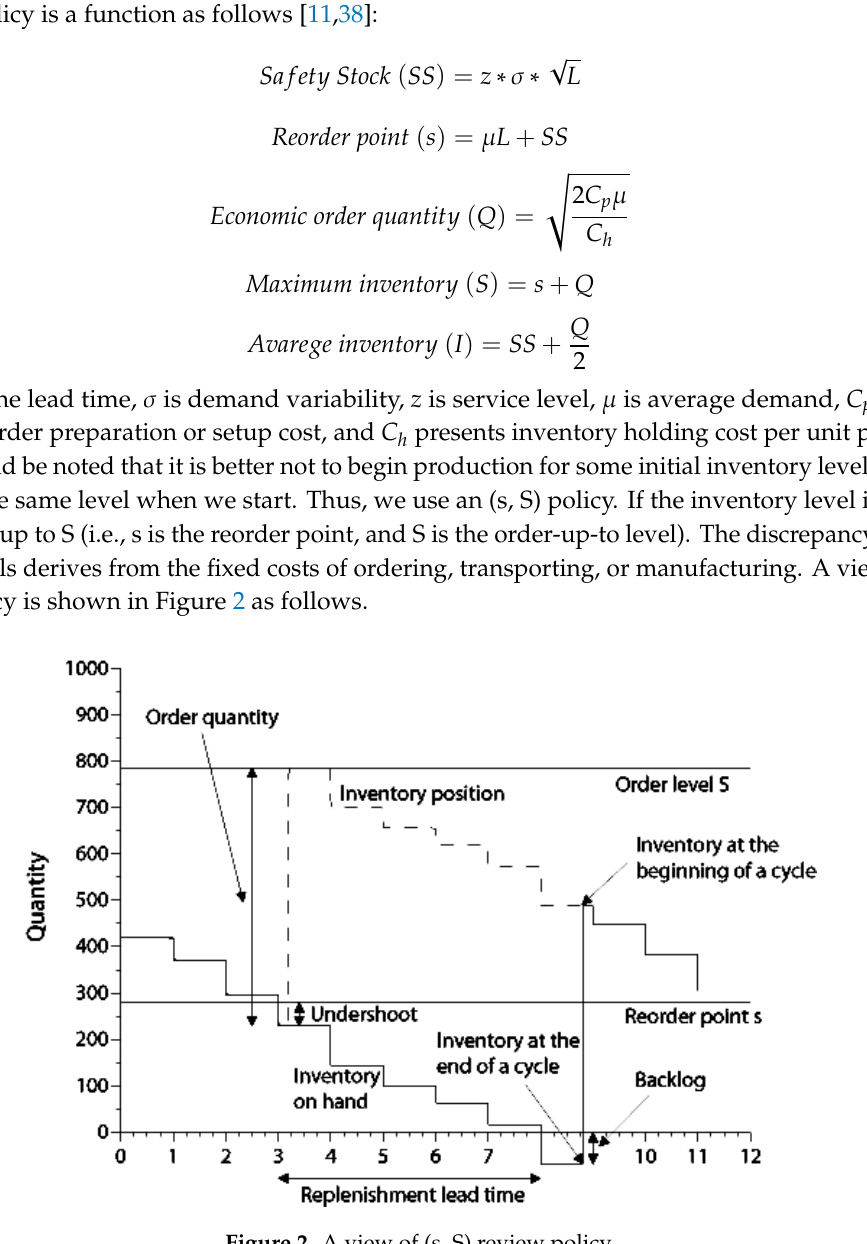
Figure 2. A view of (s, S) review policy.